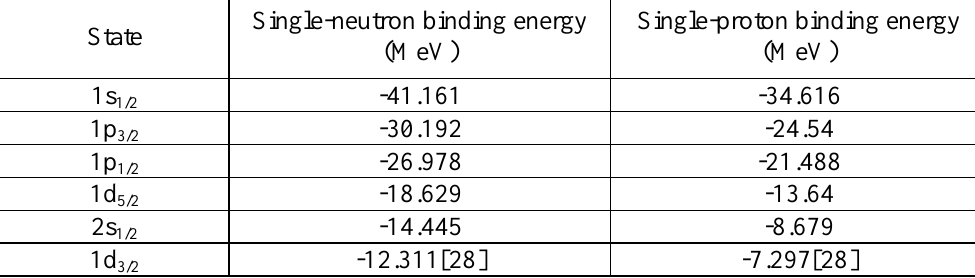
Table 8: Single-nucleon binding energies for 31